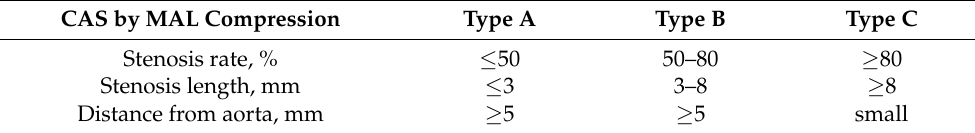
Table 1. Morphologic grading of celiac artery stenosis (CAS) cuased by median arcuate ligament (MAL) compression.